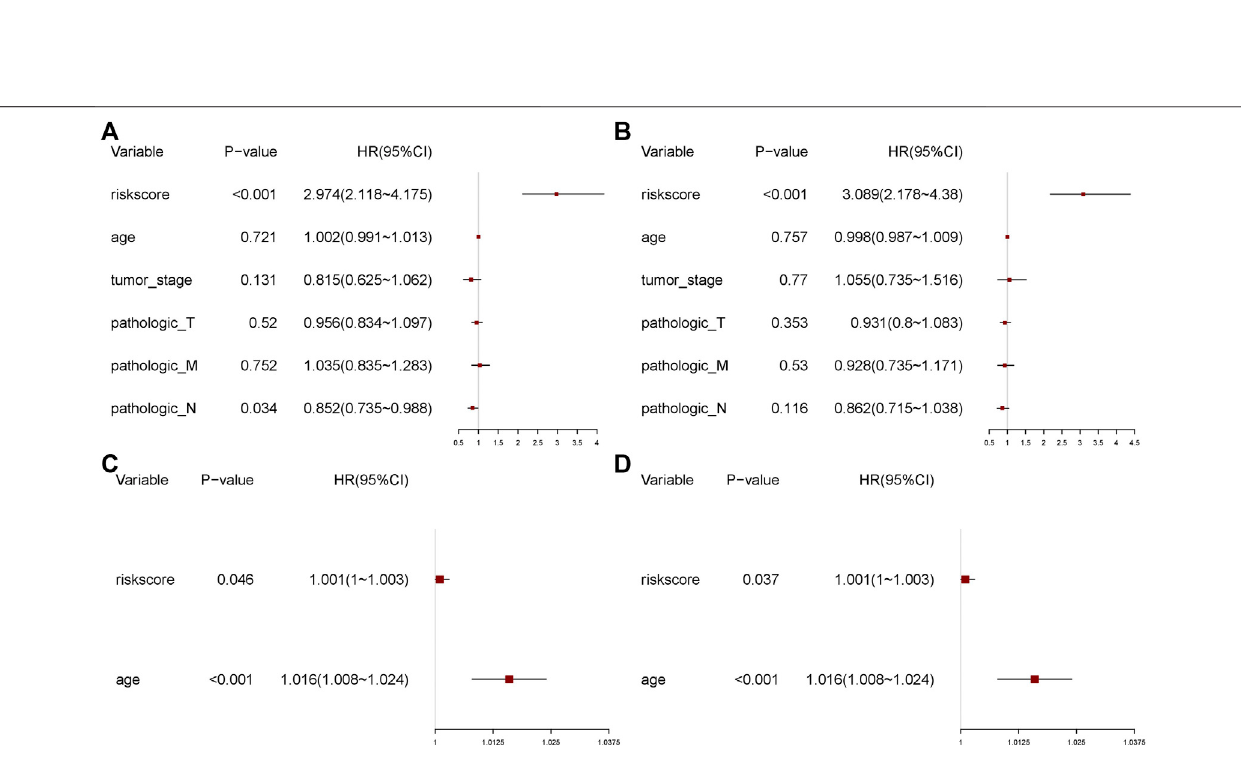
FIGURE 10 | Prediction performance of the TIDE score. (A) Difference in TIDE scores in the high- and low-risk groups. (B) ROC curve.